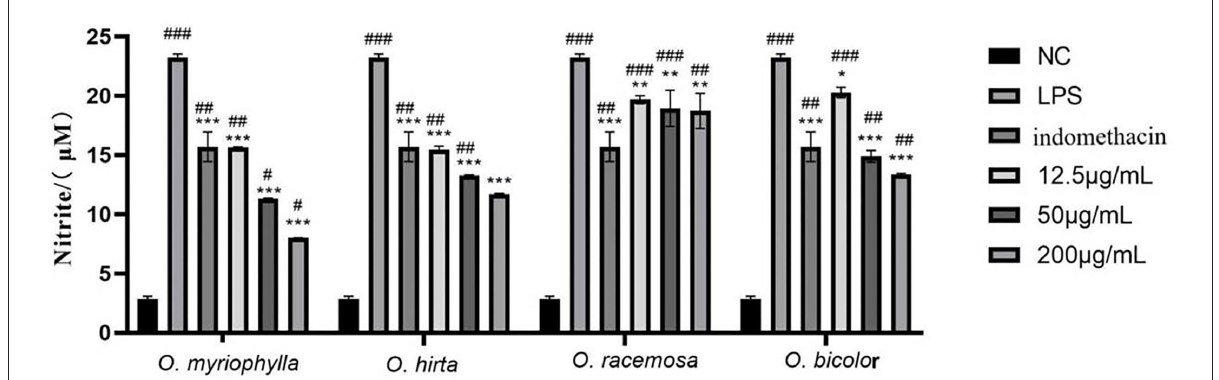
FIGURE9 Effects of the total extracts of the four Oxytropis on NO production in LPS-induced mouse RAW 264.7 macrophages (NC, blank control group; LPS, 1 µ g/mL LPS group; indomethacin: 100 µ M indomethacin + 1 µ g/mL LPS group. Compared with the NC group, # P < 0.05, ## P <